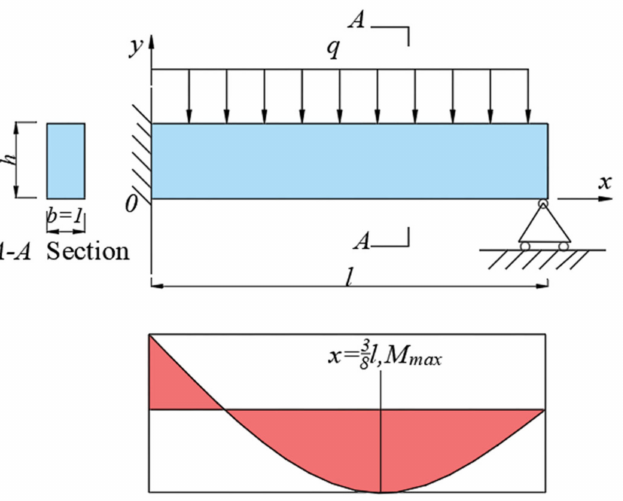
Figure 7. Force model and bending moment diagram with a fixed-freely-supported